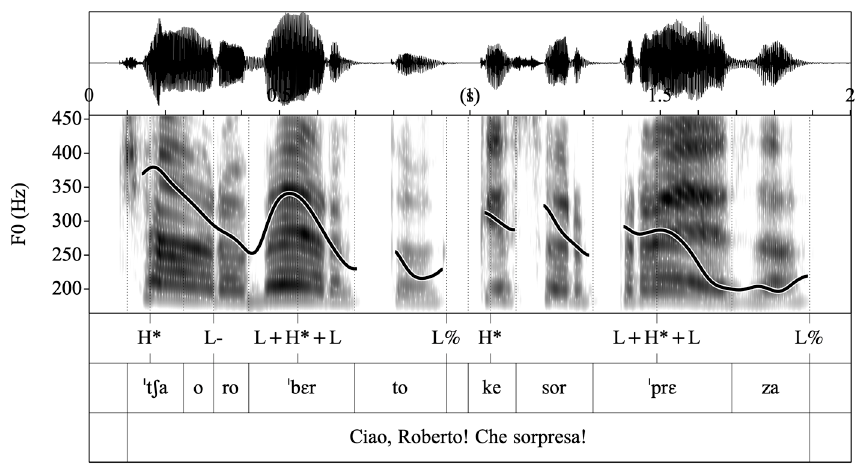
Figure 17. Waveform, spectrogram and F0 trace of the what -exclamative Che buon profumino! in L2 Italian (F32, level B1) produced with the target-like L+H*+L L% pattern.